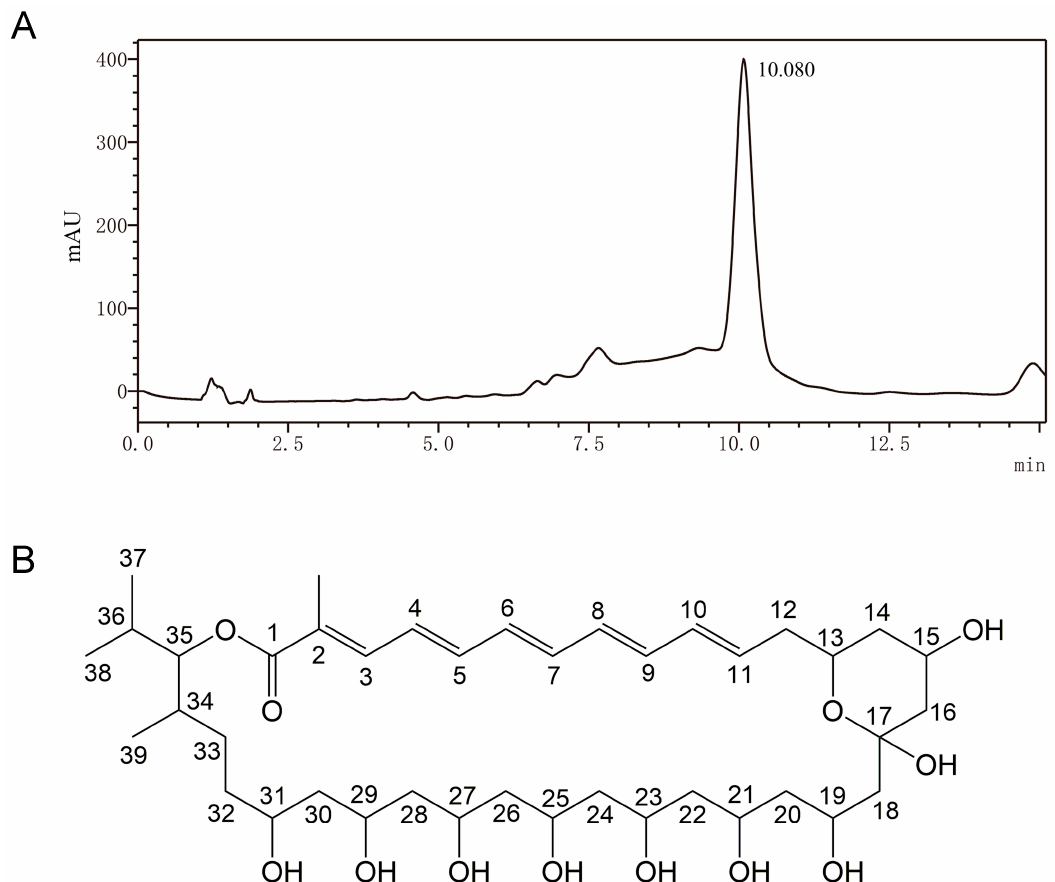
Figure 5. HPLC analysis and structure of roflamycoin produced by S. alfalfae XN-04. ( A ) HPLC analysis of Fr. 5 at 363 nm. ( B ) The structure of roflamycoin produced by S. alfalfae XN-04.